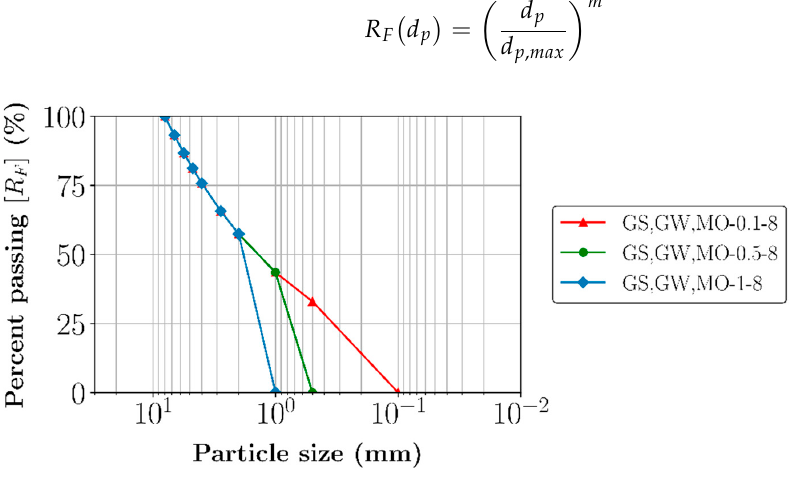
Figure 6. Particle size distributions for the packed beds composed of the different sized mixtures.